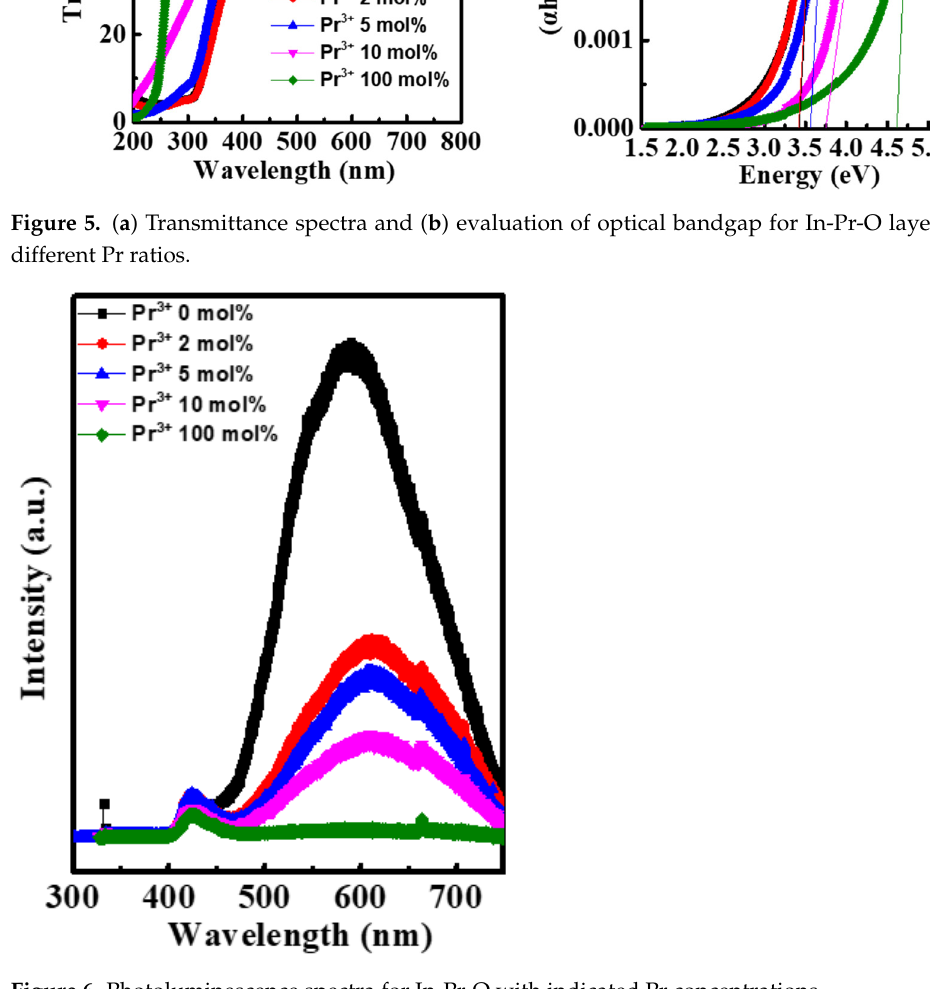
Figure 6. Photoluminescence spectra for In-Pr-O with indicated Pr concentrations.